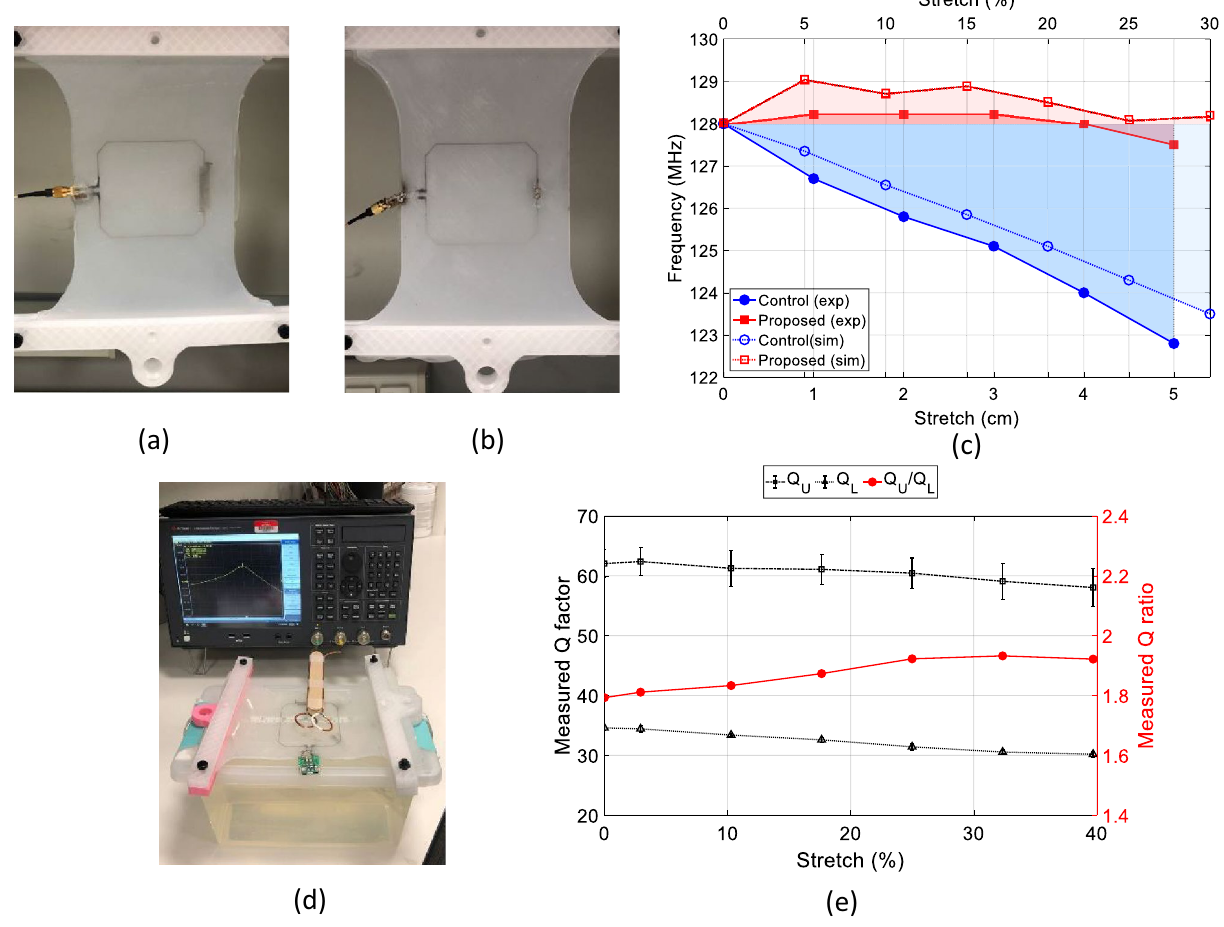
Figure 3. Fabricated prototypes of the ( a ) proposed and ( b ) control coils attached to a stretch testing rig. ( c ) Simulated and measured frequency shift with strech for the proposed (red) and control (blue) coils, indicating improved resonance frequency stability with stretching for the proposed coil. ( d ) Proposed coil prototype placed on a cylindrical phantom with a tape measure for stretching measurement. ( e ) Measured loaded Q L and unloaded Q U quality factors (black) of the proposed coil and their ratio Q U /Q L (red), indicating that the coil losses are dominated by the losses in the changes with stretching were reordered. To more clearly portray the coil performance, the resonance frequency is plotted against the degree of stretch, as shown in Fig. 3c, where the curves indicate the actual frequency change of the control (blue) and proposed (red) coils, and the shaded areas help to visualize the total frequency shift. Figure 3c shows both simulated (line with empty markers) and measured (lines with solid markers) changes in resonance frequency with stretching, illustrating that the measured data agree well with the simulated results and demonstrating an improved frequency stability of the proposed coil. In particular, at the measured maxi- mum stretch of 5 cm (corresponding to ~ 27% stretching), the frequency shift for the proposed coil is only 0.5 MHz (0.4%) as compared to > 5 MHz (> 4%) for the control coil, which indicates a tenfold reduction in fre- 78, σ 0.8 S/m) with a quency shift. Figure 3d shows the proposed coil placed on a rectangular phantom ( ε r = = tape measure to track dimension changes with stretching. The quality factor of the proposed coil was measured using a pickup probe when the coil was loaded with this phantom Q L and without the phantom Q U . The quality Q U / Q L is around two, which means that the majority of coil losses are coming from the phantom ratio Q ratio = and not from the coil itself. Although, the Q ratio is not very high as compared to traditional copper-base RF coil